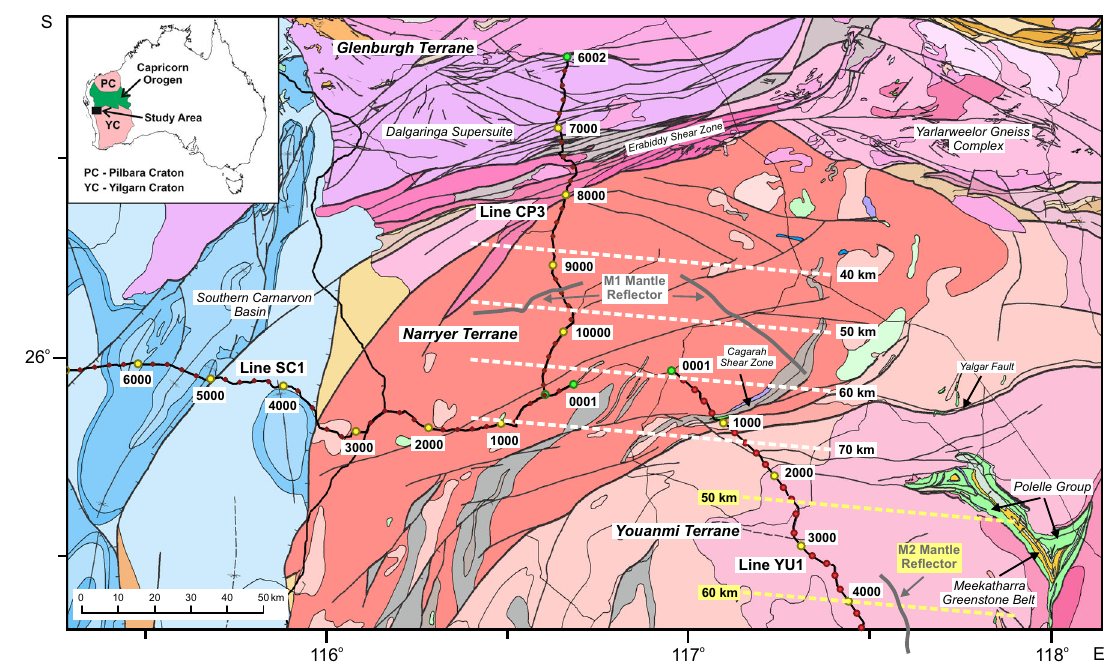
Fig. 1 Geology of the northwest Yilgarn Craton showing the location of seismic pro fi les. The Narryer Terrane comprises exhumed amphibolite and granulite facies gneissic rocks of the northwest margin of the Archaean Yilgarn Craton, the core of which is the Youanmi Terrane. The Glenburgh Terrane accreted to the Yilgarn Terrane during formation of the West Australian Craton at 1.965 – 1.950 Ga, and the subsequent Capricorn Orogen reworked the collision zone, including the northern part of the Narryer Terrane now represented by the Yarlarweelor Gneiss Complex. Dashed white lines — depth contours of the planar interface that approximates the M1 mantle re fl ector, dashed yellow lines — depth contours of the planar interface that approximates the M2 mantle re fl ector, solid grey lines — re fl ection points on the interfaces, common depth points (CDP) are indicated every 200 by fi lled circles along the seismic lines. Overview of geological units: blue — Palaeozoic sedimentary rocks, orange/brown – Proterozoic sedimentary rocks, grey — Proterozoic and Archaean metasedimentary rocks, green/yellow — volcanic greenstone rocks, pink/red — granites and granitic